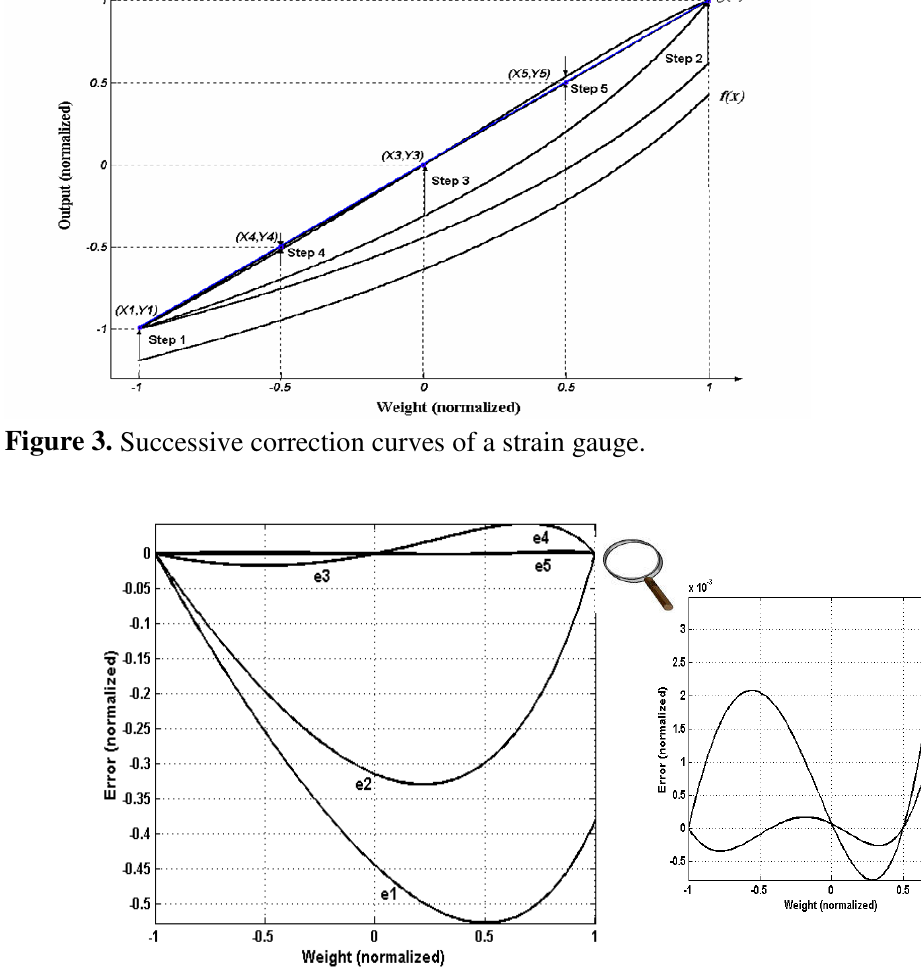
Figure 4. Corresponding errors